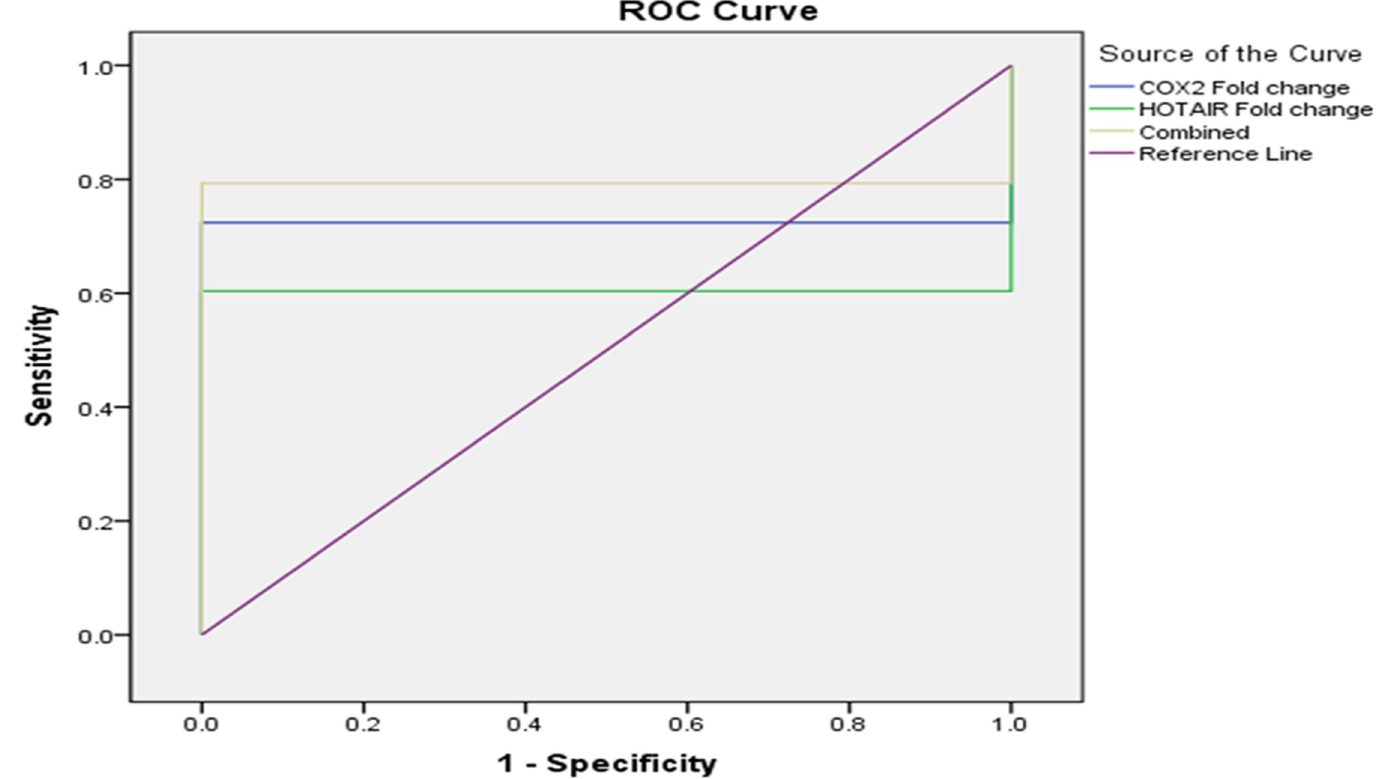
Fig 2. ROC curve for validation of lnc-Cox2 and HOTAIR to differentiate SLE patients from healthy subjects.